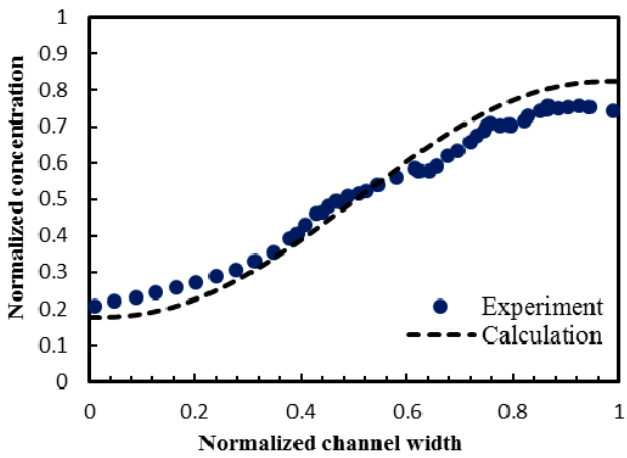
Figure 5. Validation of the numerical results for normalized concentration profile across the channel width using experimental data (Wu and Li [18]).